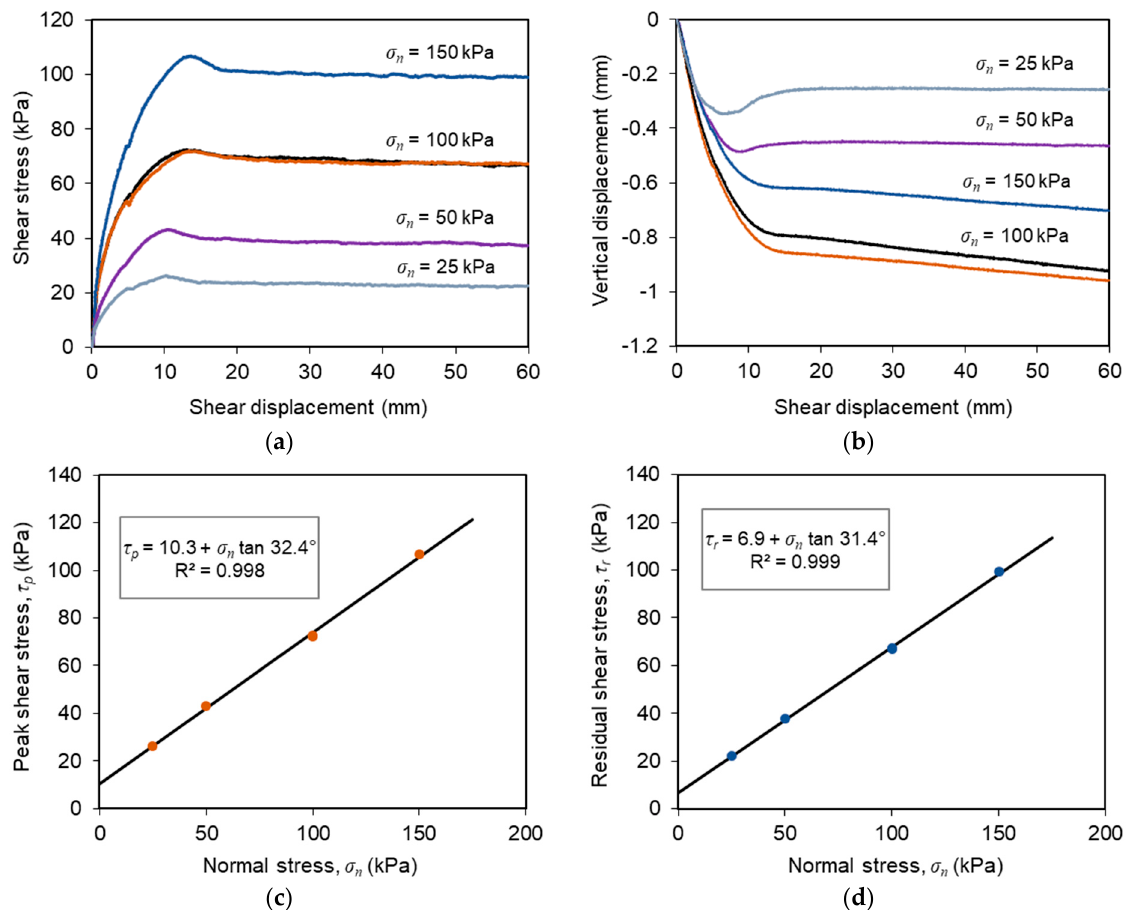
Figure 4. Results from conventional large-scale direct shear tests (tests T-1 to T-5): ( a ) Shear stress-shear displacement curves; ( b ) Vertical displacement of the loading plate centre; ( c ) Peak shear strength envelope; ( d ) Residual shear strength envelope.